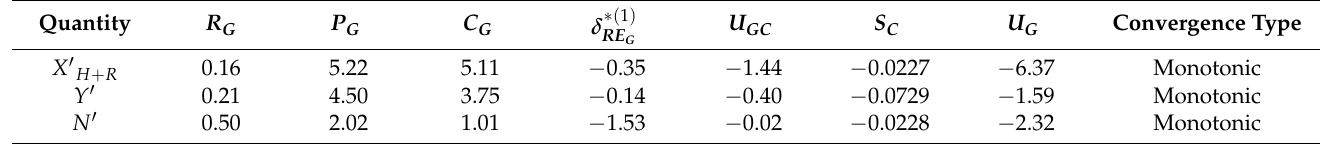
Table 9. Grid uncertainty analysis for static drift motion by water–air flow simulation. δ and U G are % S 3